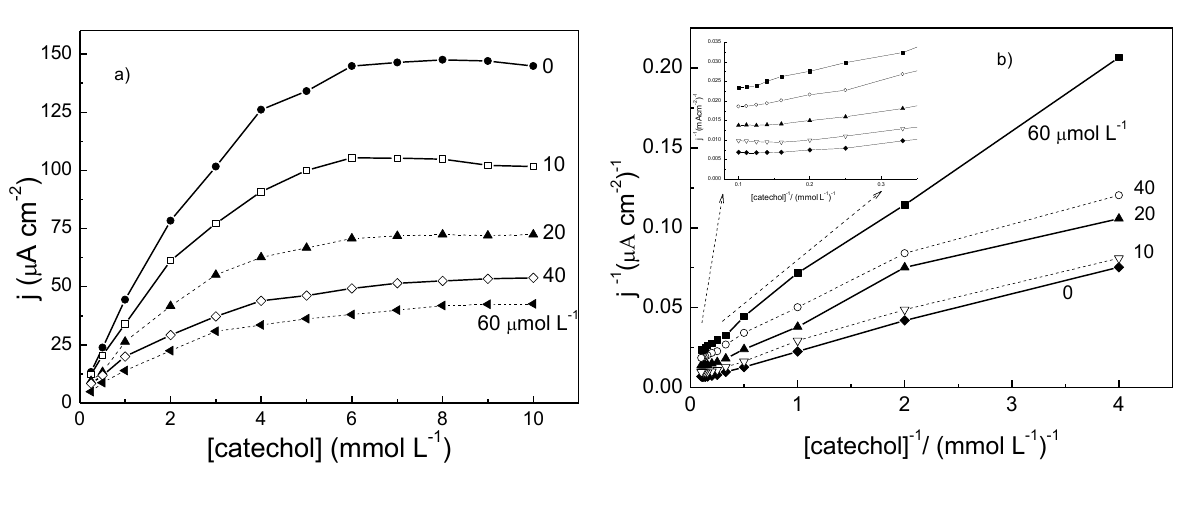
Figure 7. ( a ) Current response and ( b ) Lineweaver-Burk plot vs. concentration of catechol for PPy/Tyr films at different concentrations of benzoic